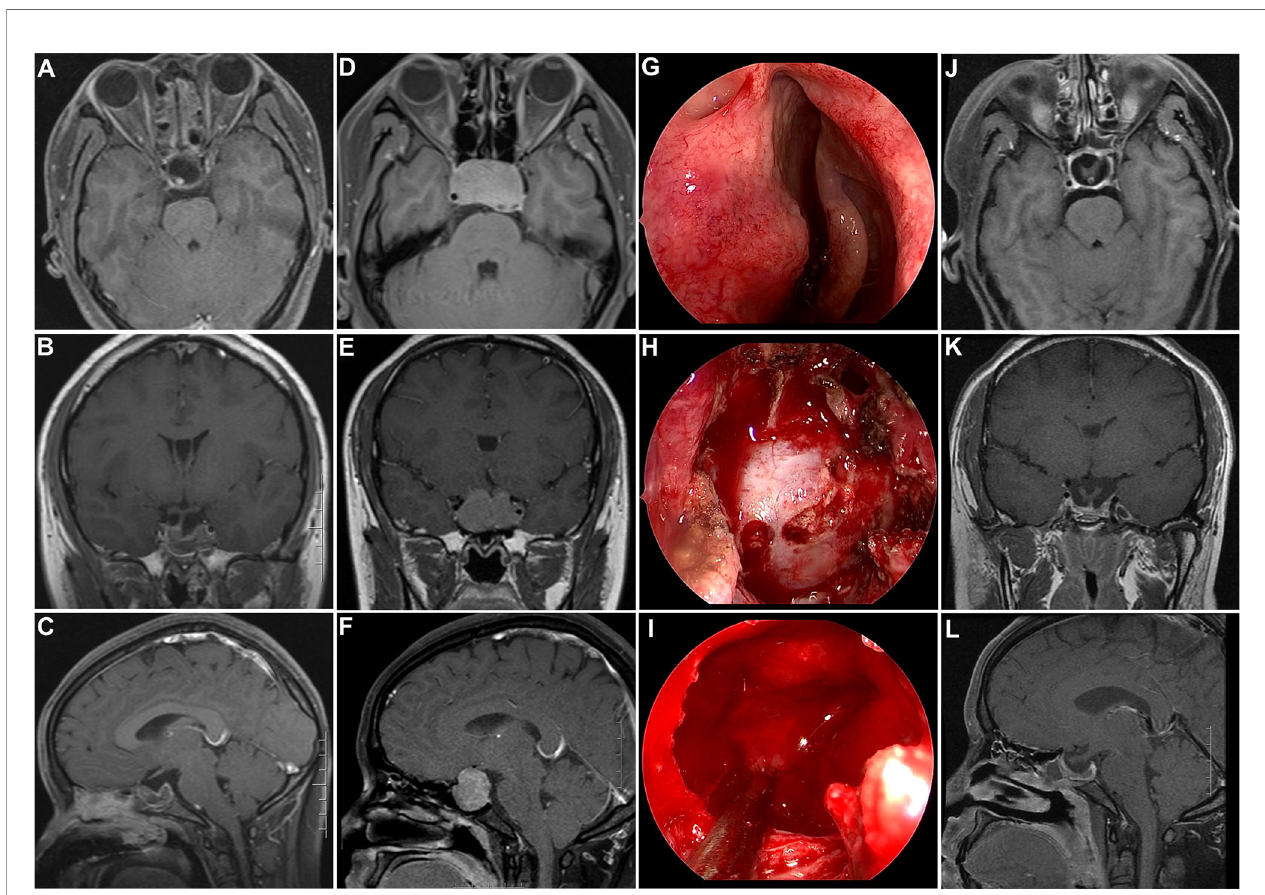
FIGURE 1 | Illustrative case of a recurrent non-functional PA after prior transsphenoidal surgery. (A – C) Postoperative post-contrast T1-weighted MR images showing GTR after initial transsphenoidal surgery. (D – F) Post-contrast T1-weighted MR images showing tumor recurrence after 6 years. (G – I) Intraoperative photographs during repeat transsphenoidal surgery. (H) Wide sphenoidotomy was performed and a dural defect caused by the initial surgery was observed. (I) After tumor removal, the compressed pituitary and intact diaphragm sellae were displayed. (J – L) Post-contrast T1-weighted MR images acquired 3 months after repeated surgery showed complete tumor removal; additionally, both the pituitary and stalk were